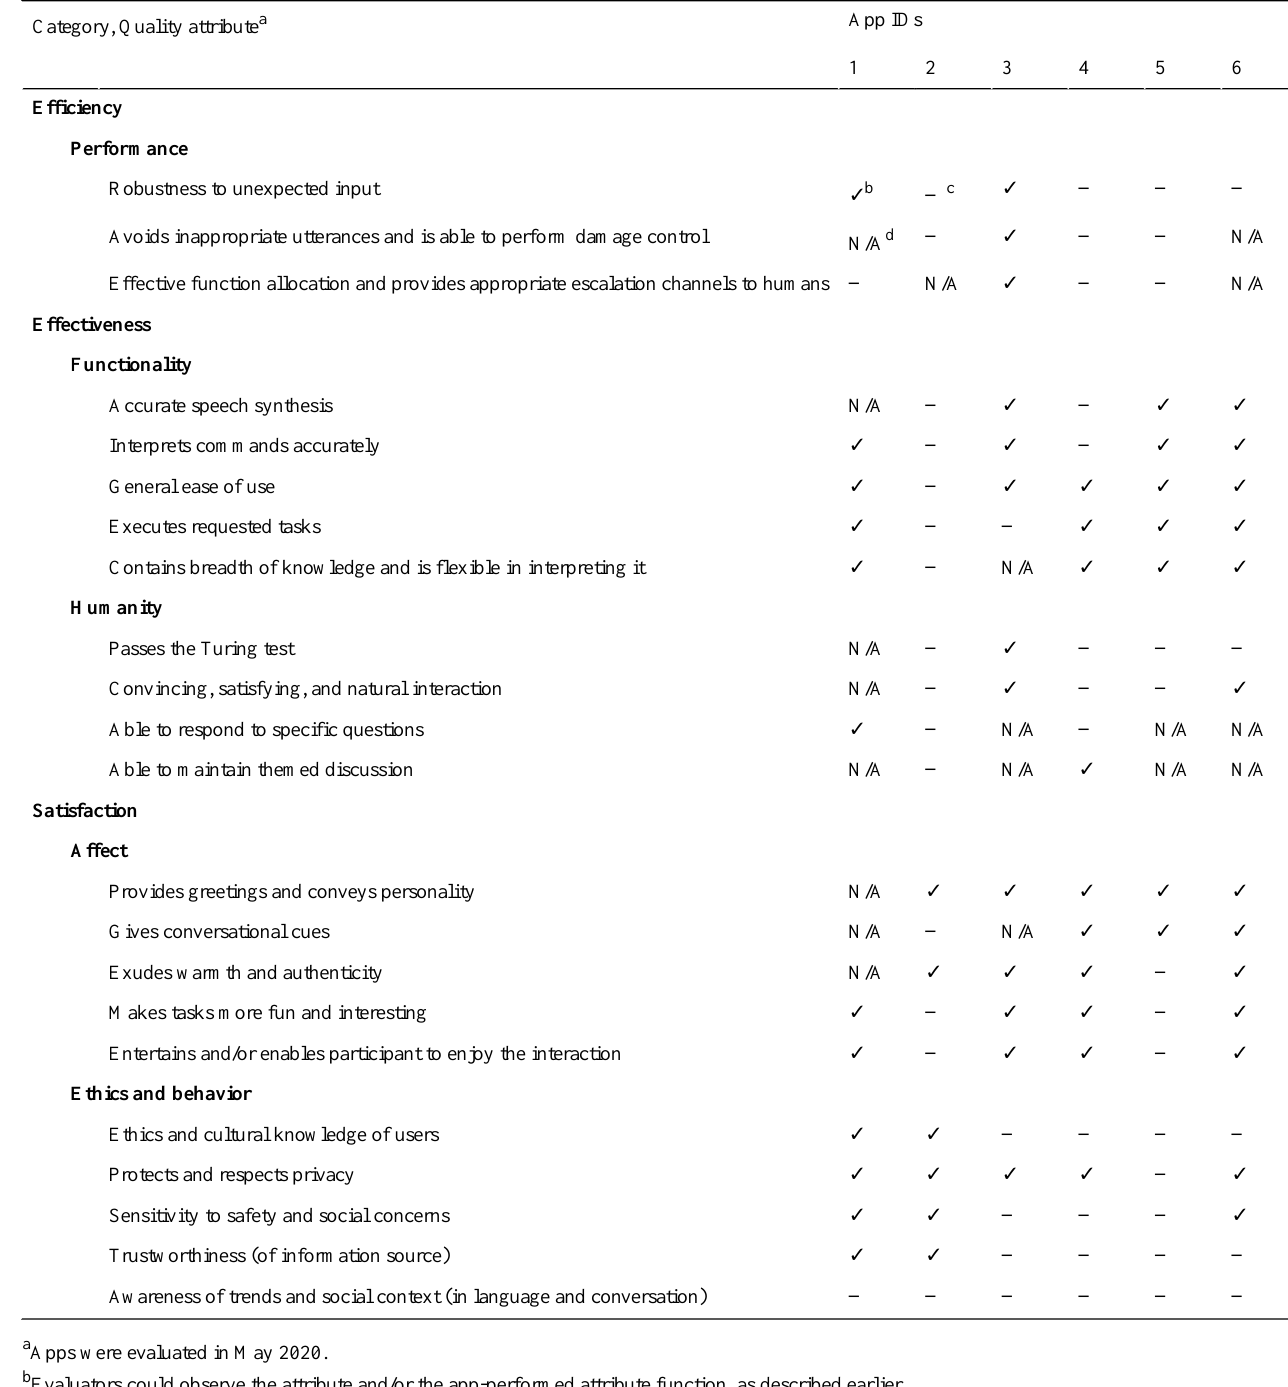
Table 2. Assessment tool informed by the framework developed by Radziwill and Benton and evaluation of apps by the research